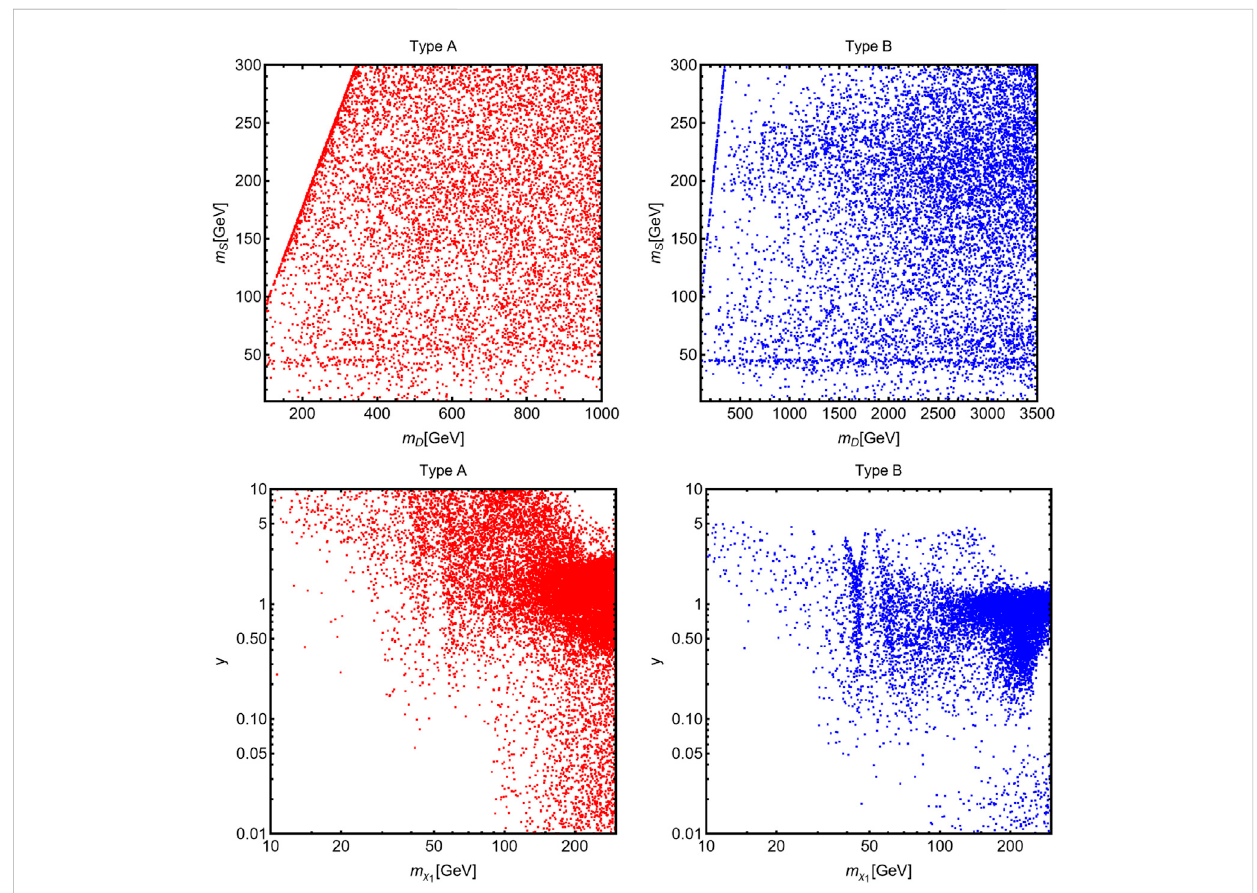
FIGURE 7 Outcomeofthelargeparameter scanofthesinglet – doubletfermionicmodelcoupledwithtwoHiggs-doublet fi elds.Themodelpointscompatible with the CDF M W value and the DM constraints are shown in the ( m D , m S ) plane ( fi rst row) and ( m χ respectively, to the type-A and type-B con fi gurations of the couplings of the fermions with the Higgs doublets.